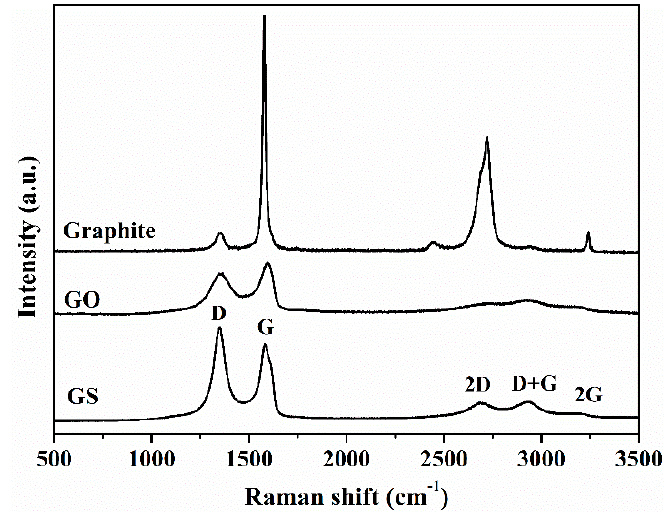
Figure 2. Raman spectra of natural graphite, GO, and GS.